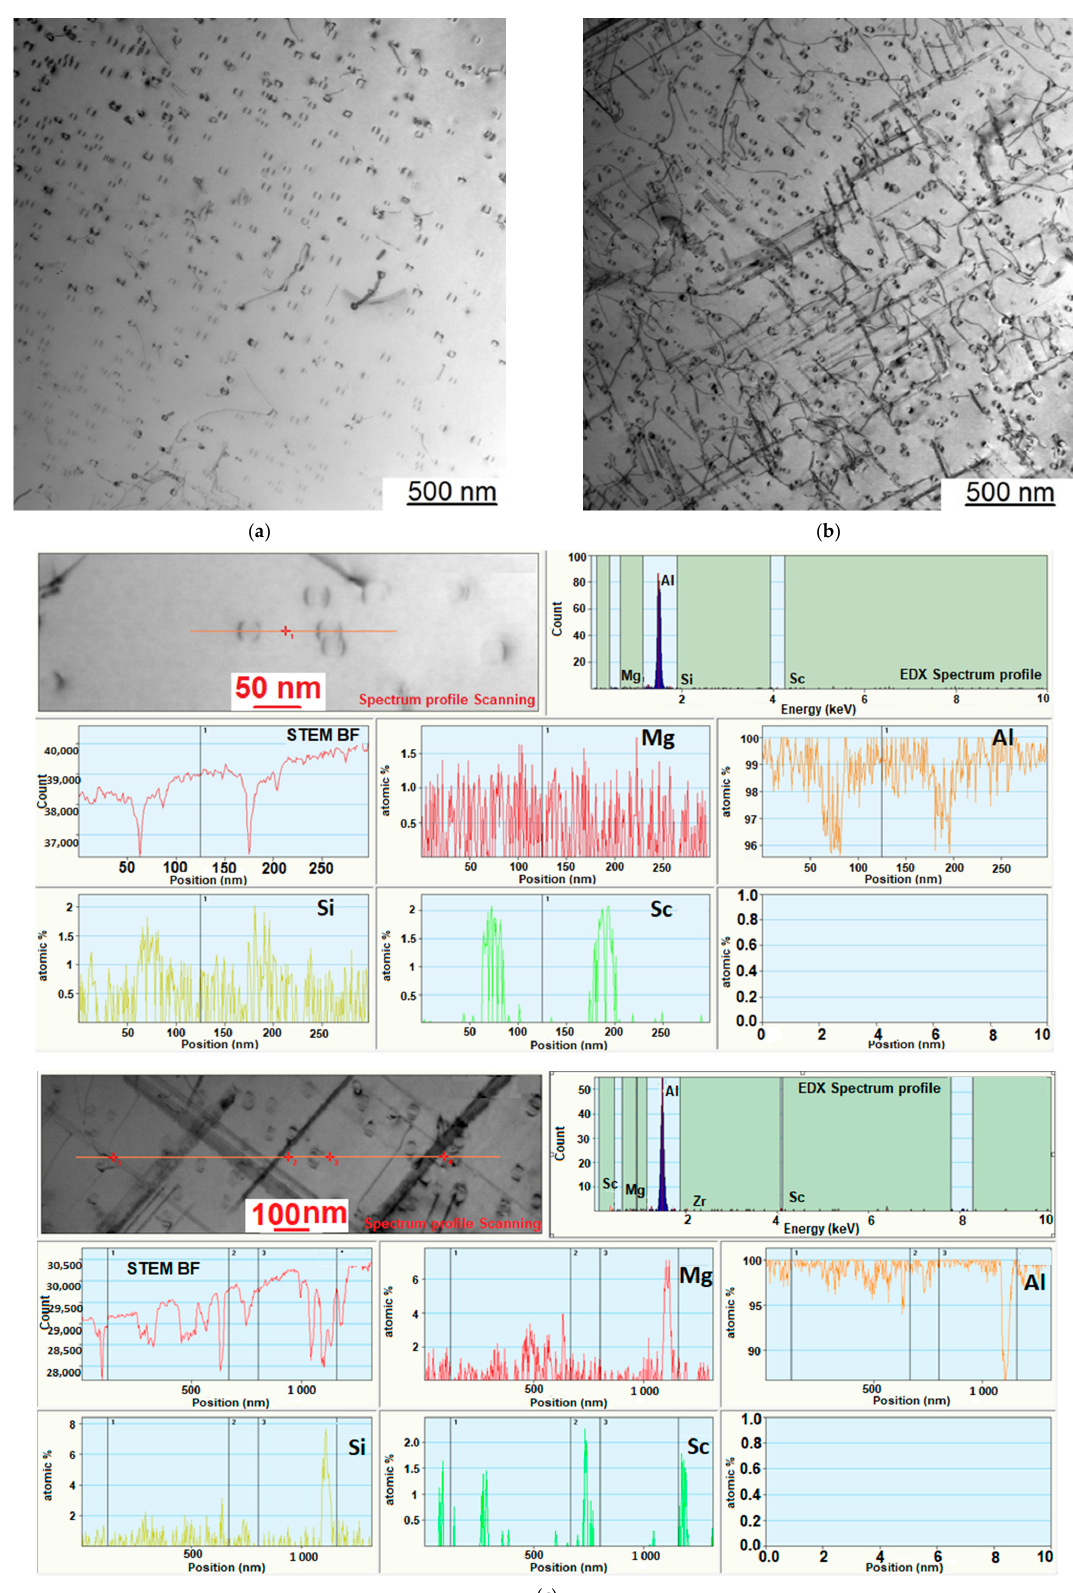
Figure 11. ( a ) Al 3 Sc coherent and semi coherent particles particles; ( b ) Al 3 Sc coherent and semi coherent particles + Mg 2 Si (rod-like) particles ( c ) EDS profile line scan.